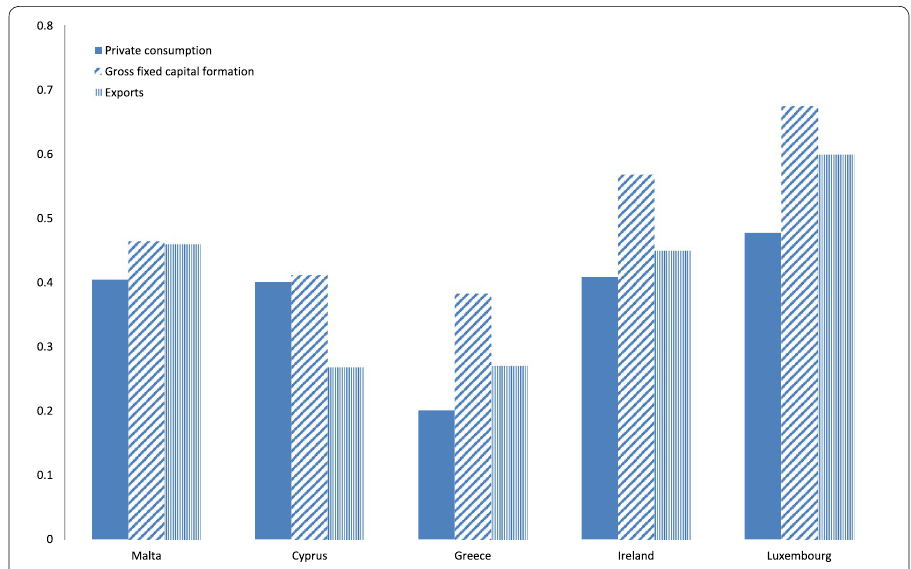
Fig. 2 Import intensities of final demand components estimated for a number of small and open euro area economies using 2010 OECD input–output